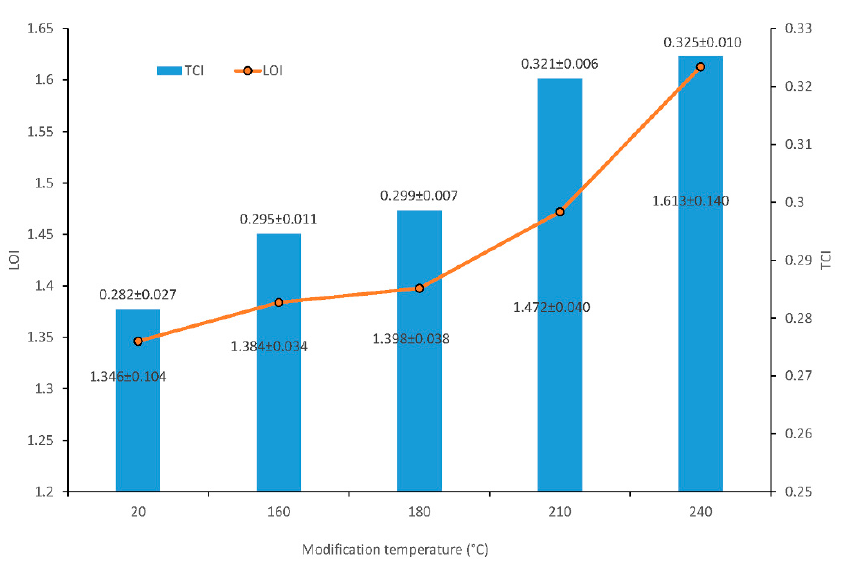
Figure 4. Total crystallinity index (TCI) and lateral order index (LOI) values of wood cellulose before and after thermal treatment.